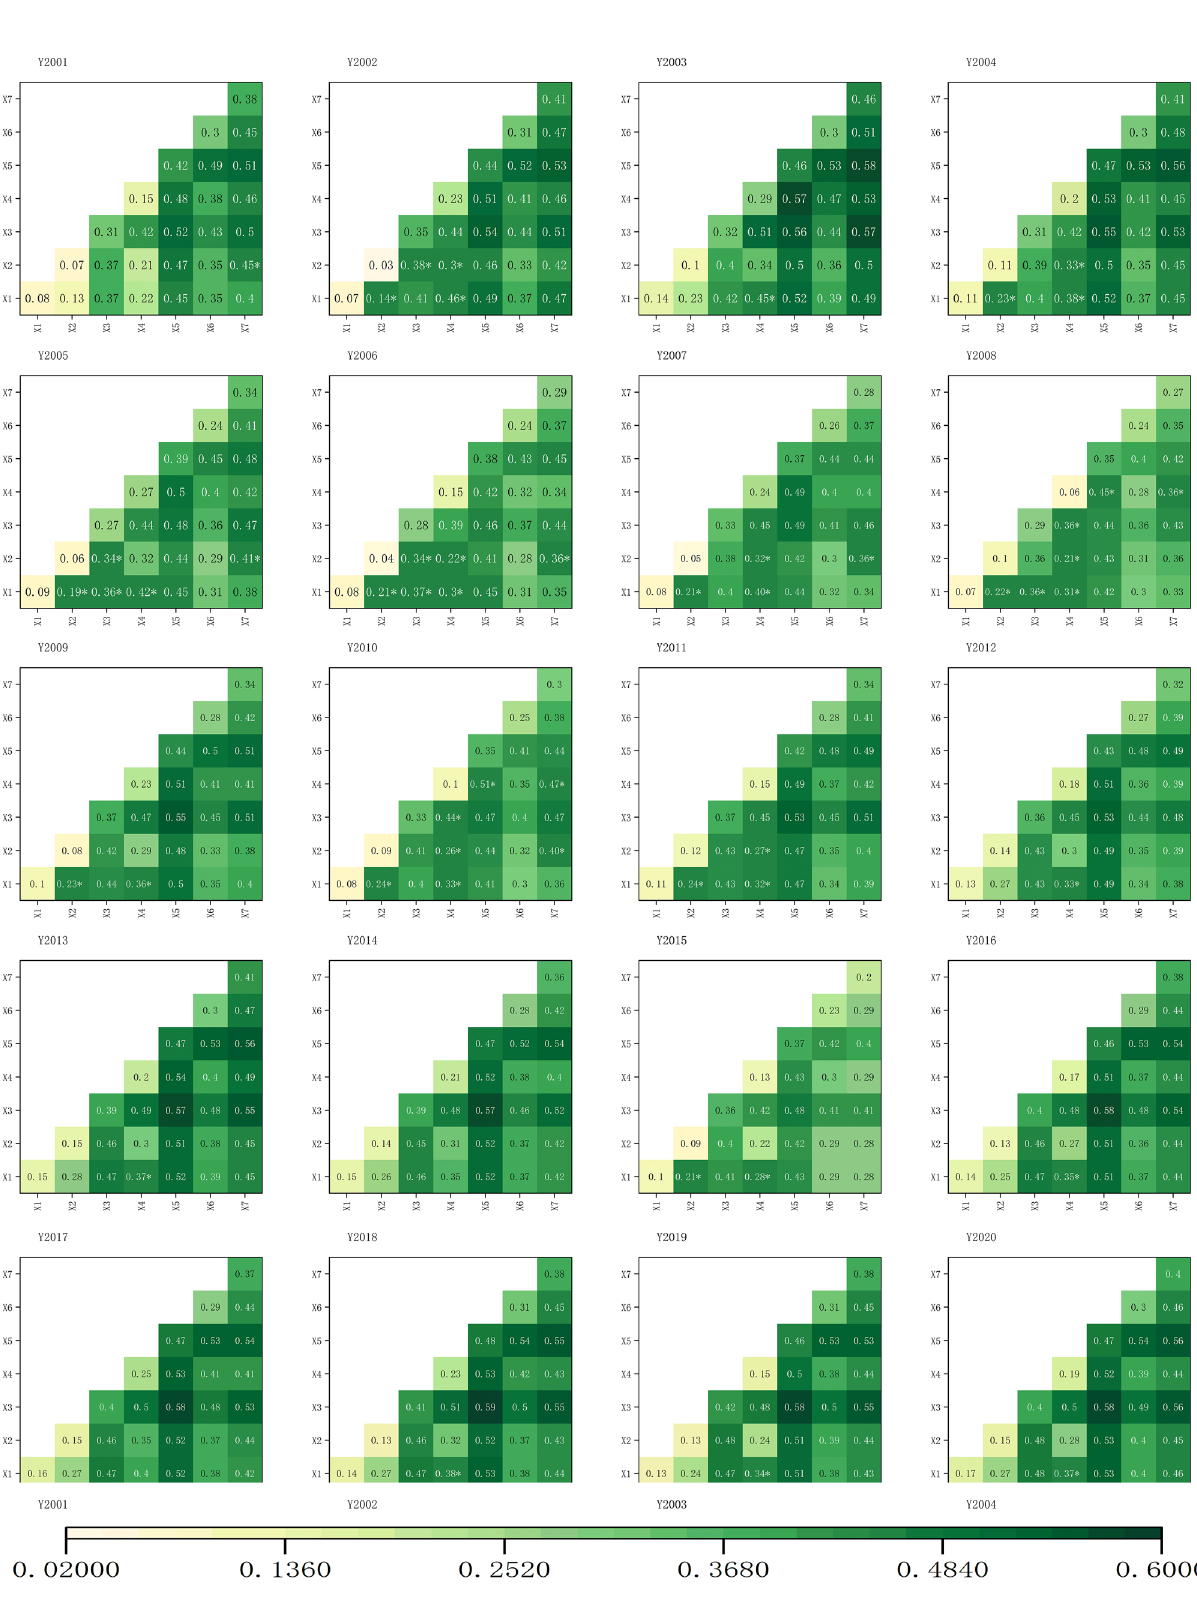
Figure 5. Interaction Results Plot (where with * is a two-factor nonlinear enhancement, without * is linear